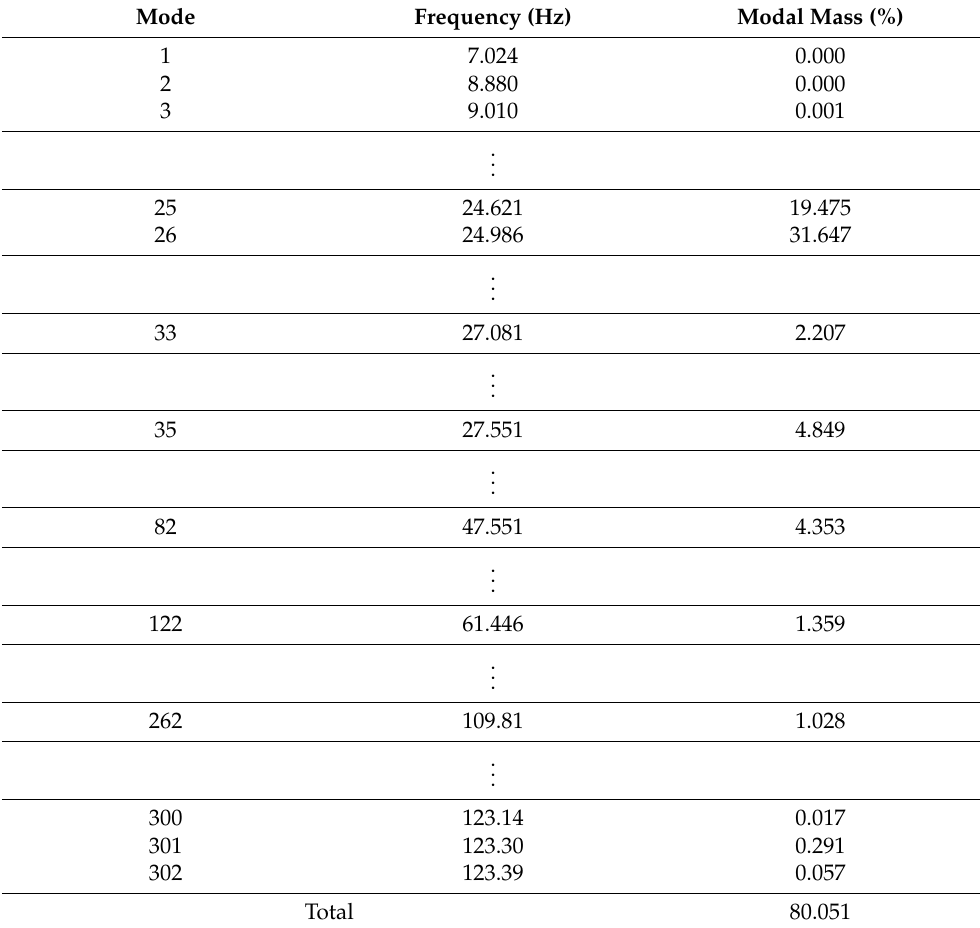
Table 3. Mode Extraction.